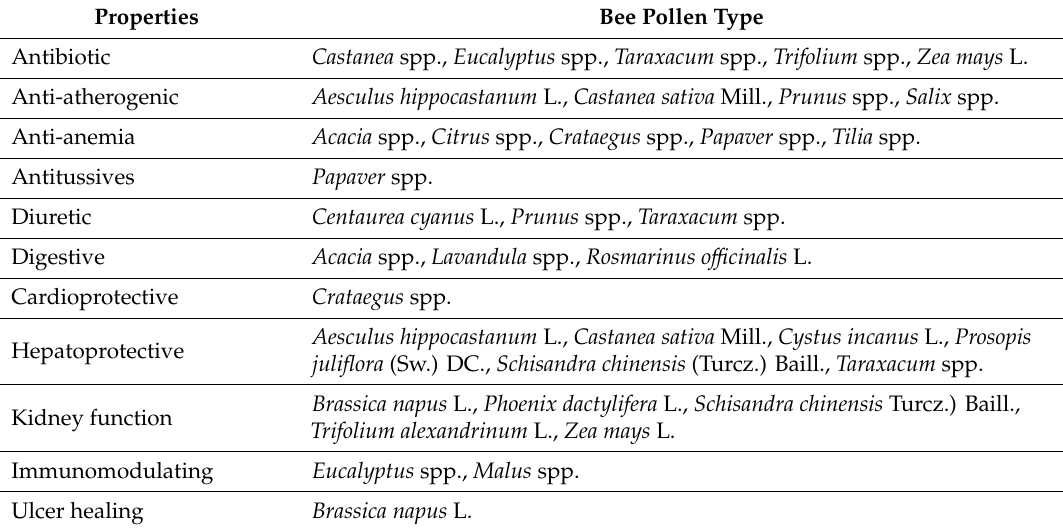
Table 1. Therapeutic properties of di ff erent pollen types in folk medicine (after